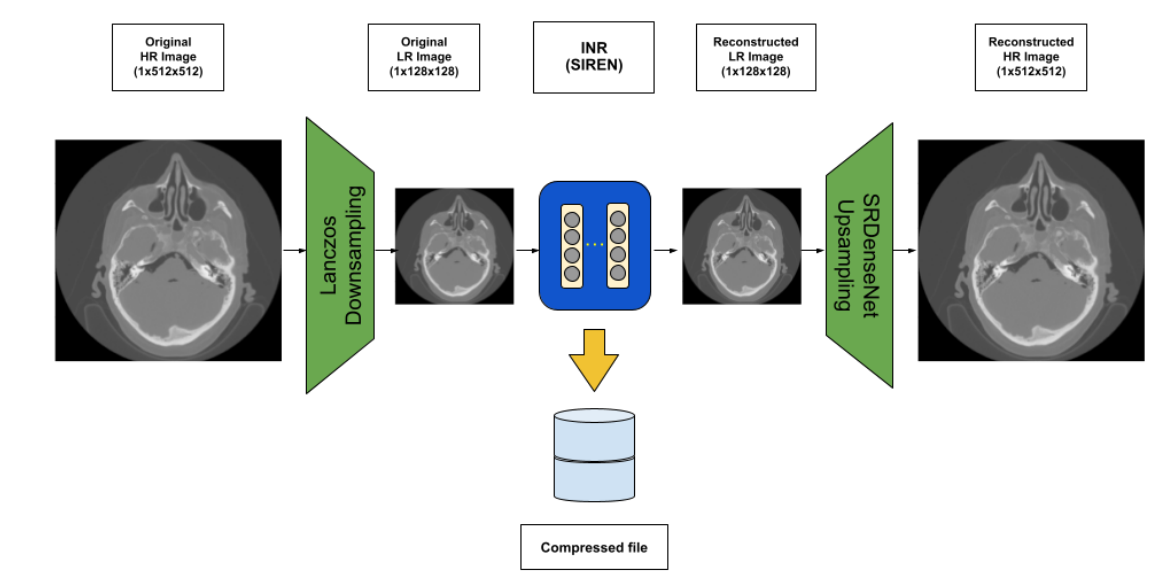
Figure 1. Our suggested architecture using INR (in this work, SIREN) to compress high-resolution (HR) medical